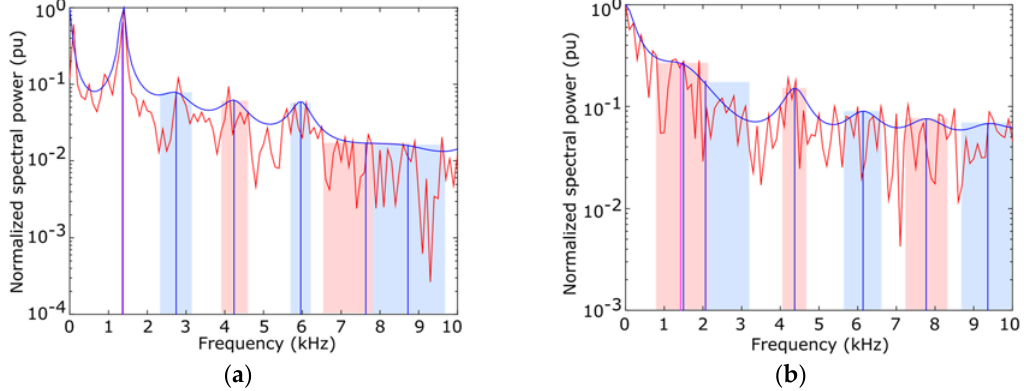
Figure 6. Example of results obtained with LPC analysis. ( a ) (cid:1872) = 0.80 (cid:1858) (cid:3033) = (cid:4670)36 , 810 , 682(cid:4671) (cid:1834)(cid:1878) ; ( b ) (cid:1872) = 2.00 (cid:1858) (cid:3033) = (cid:4670)1316,2191,647(cid:4671) (cid:1834)(cid:1878) .